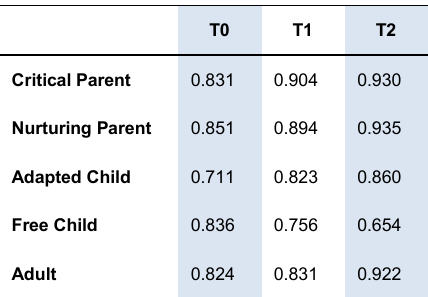
Table 2: Alpha Cronbach for T0, T1,